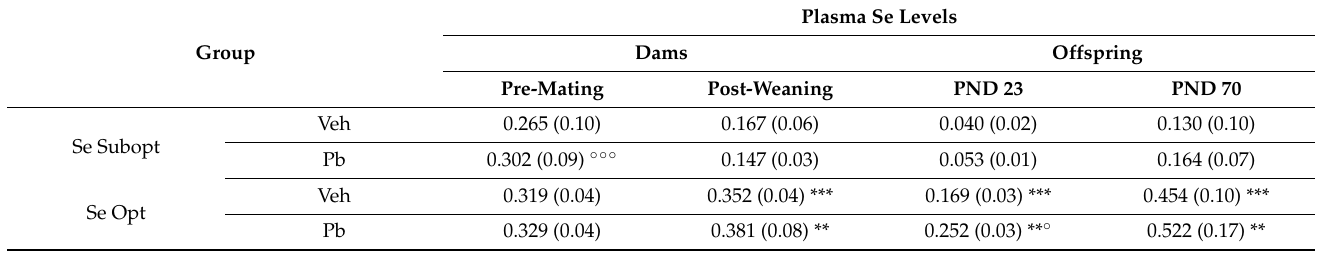
Table 1. Se concentrations in plasma of dams and offspring ( µ g Se/mL): medians and IQRs.